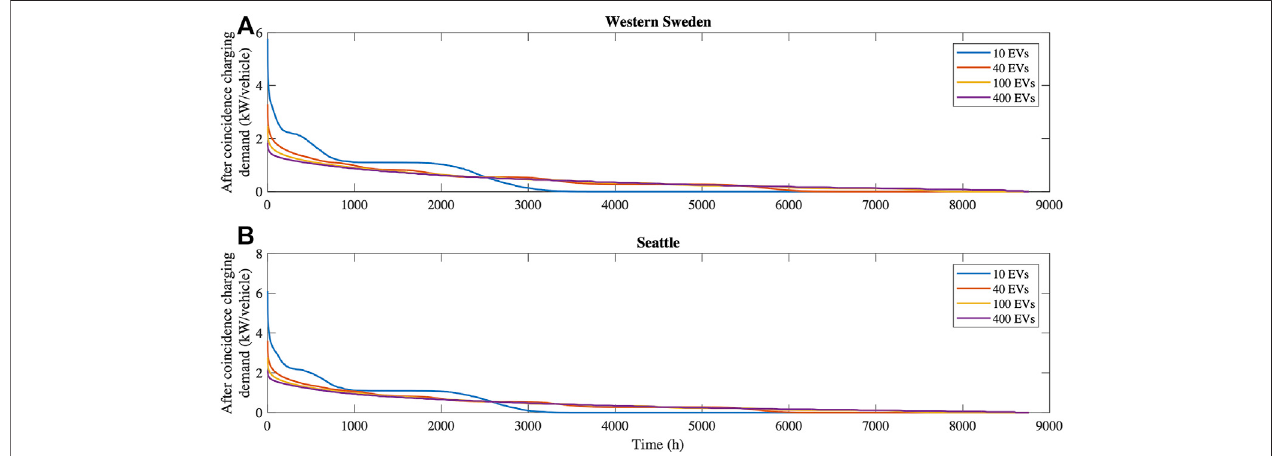
FIGURE6| After-coincidence charging power demanddurationcurve over afullyear for10, 40,100and 400number ofEVs.Resultsforwestern Sweden (A) and Seattle (B) . The nominal charging power is 11 kW, the electricity demand per km is assumed to be 0.2 kWh/km and charging location is home only.